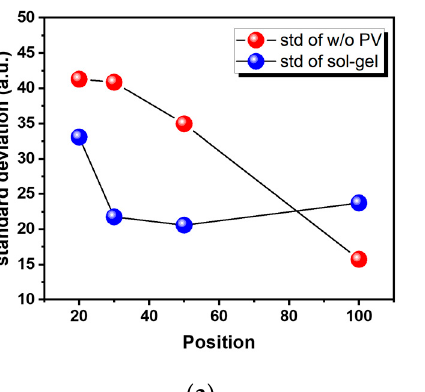
Figure A3. EL emission images of S1, and S3 presented as a 3D stereogram in ( a ) and a 2D intensity profile in ( b ).